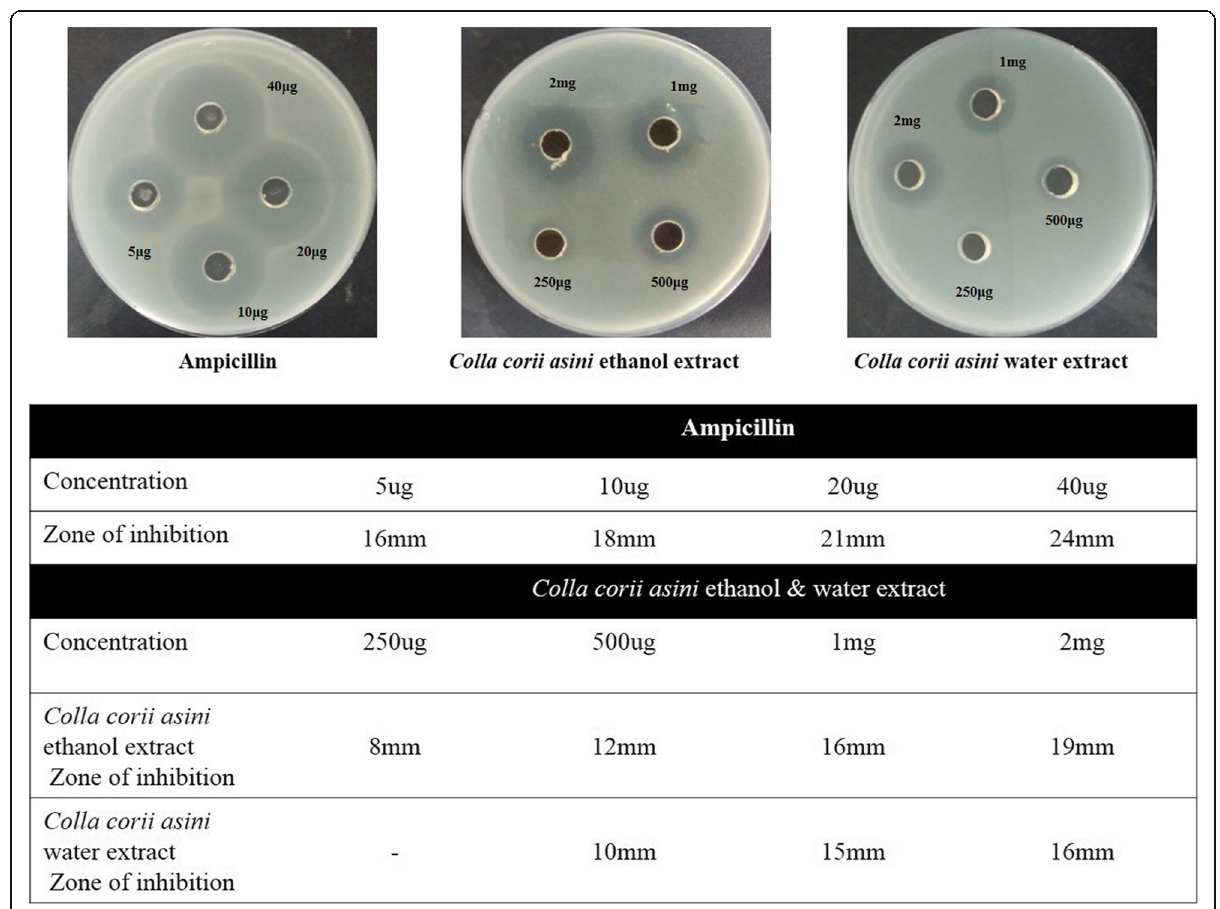
Fig. 1 The agar well diffusion assay of Colla corii asini extract. We determined the zone of inhibition for Colla corii asini extract and the positive control (ampicillin) after 24 h. The zones of inhibition with the various concentrations of Colla corii asini ethanol and water extract were greater for S. typhimurium . The Colla corii asini ethanol extract had more of a significant effect than the Colla corii asini water extract